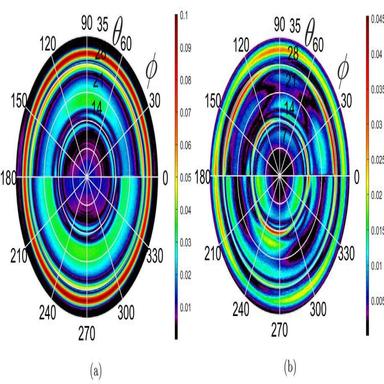
Difference amplitude P-UPS between the experimental polar plot for an aluminum plate (d = ± 1.500 0.002 mm) and the forward simulations based on the results of the inversion procedure for the isotropic (a) and orthotropic (b) cases. The colorbar is normalized to the maximum amplitude of the input signal.